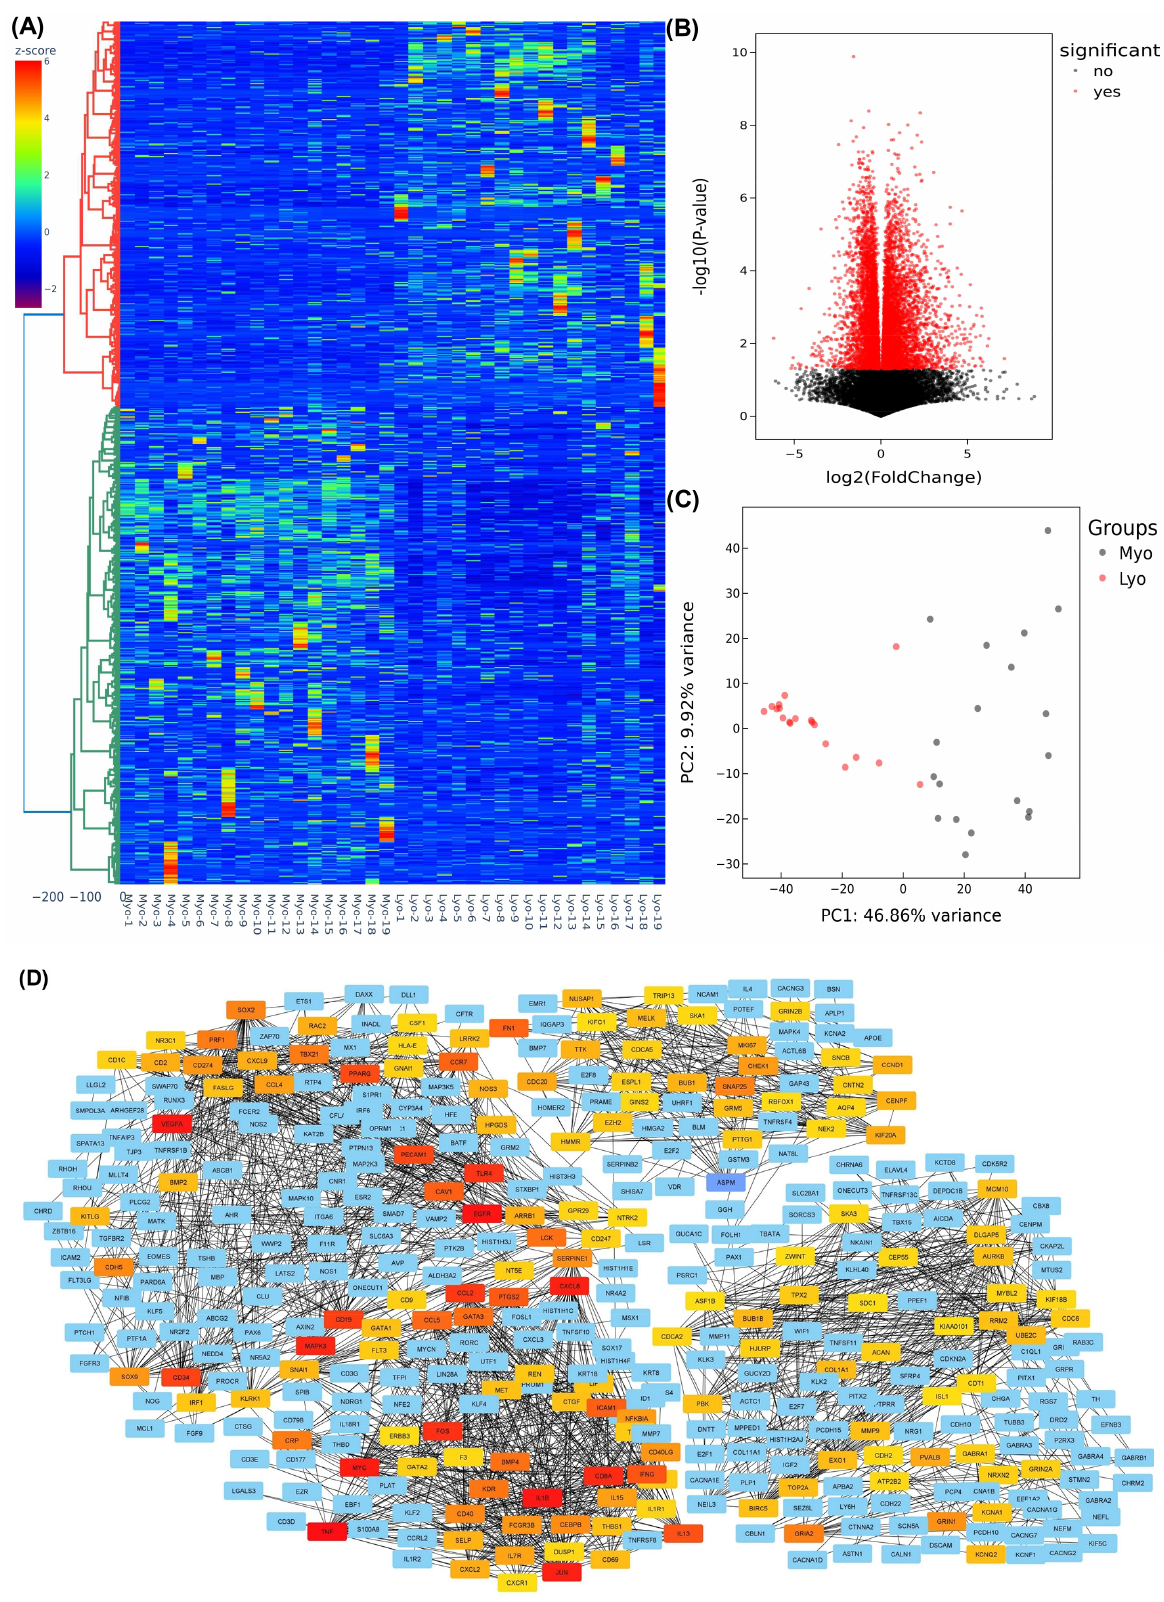
Figure 1. Heterogeneity and transcriptomic changes in leiomyomas compared to the myometrium. ( A ) Hierarchically clustered heatmap analysis of the differentially expressed transcripts (fold change ≥ 1.5, p < 0.05) in 19 paired leiomyomas and matched myometrium. Color gradient represents